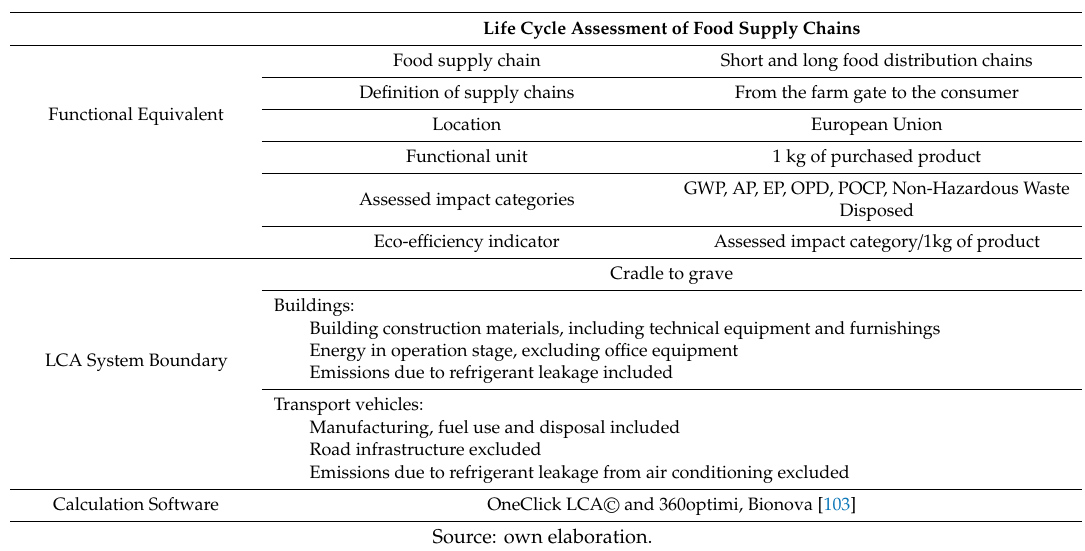
Table 5. Summary of scope /